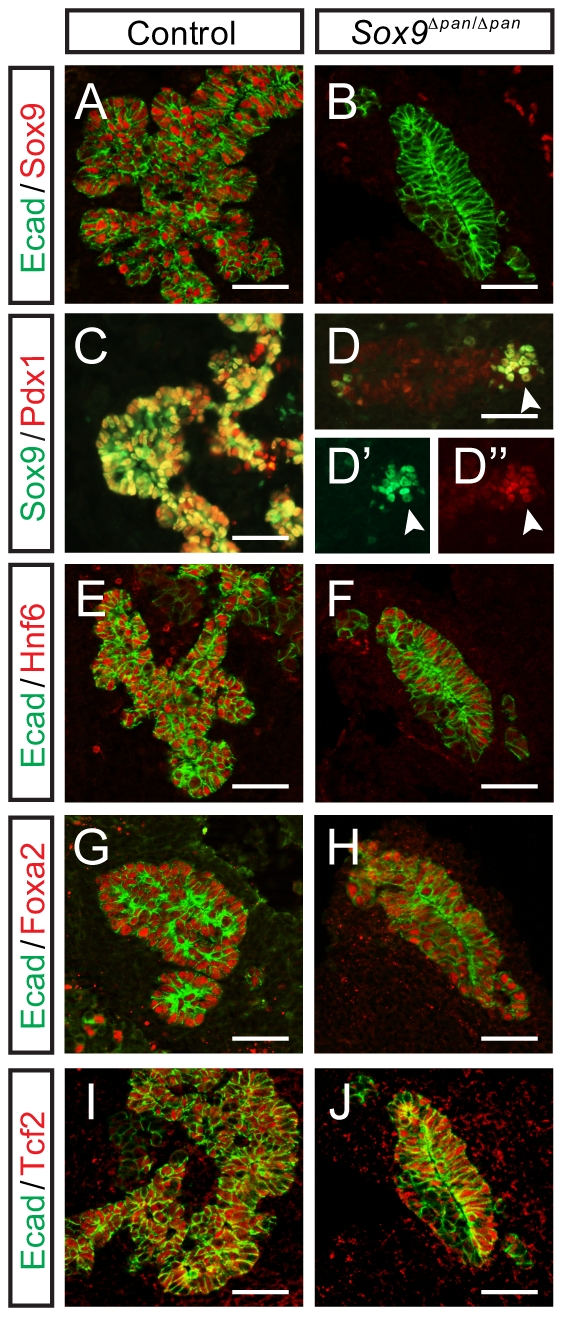
Pancreas-specific Sox9-deletion results in loss of Pdx1 by e12.5.Immunofluorescence staining of control (A, C, E, G, I) and Sox9Δpan/Δpan pancreata (B, D, F, H, J) at e12.5. Pdx1-Cre-mediated Sox9-flox recombination efficiently ablates Sox9 (B), resulting in pancreatic hypoplasia (B, D, F, H, J). (A, B, E–J) E-cadherin (Ecad) was used to visualize the Sox9− pancreatic epithelium. While loss of Sox9 does not affect expression of Hnf6 (F), Foxa2 (H), or Tcf2 (J), Pdx1 expression is reduced (D). (D) Mosaic recombination results in an unrecombined population of Sox9+ cells, which retains high levels of Pdx1 (white arrowheads). Scale bars: 50 µm.